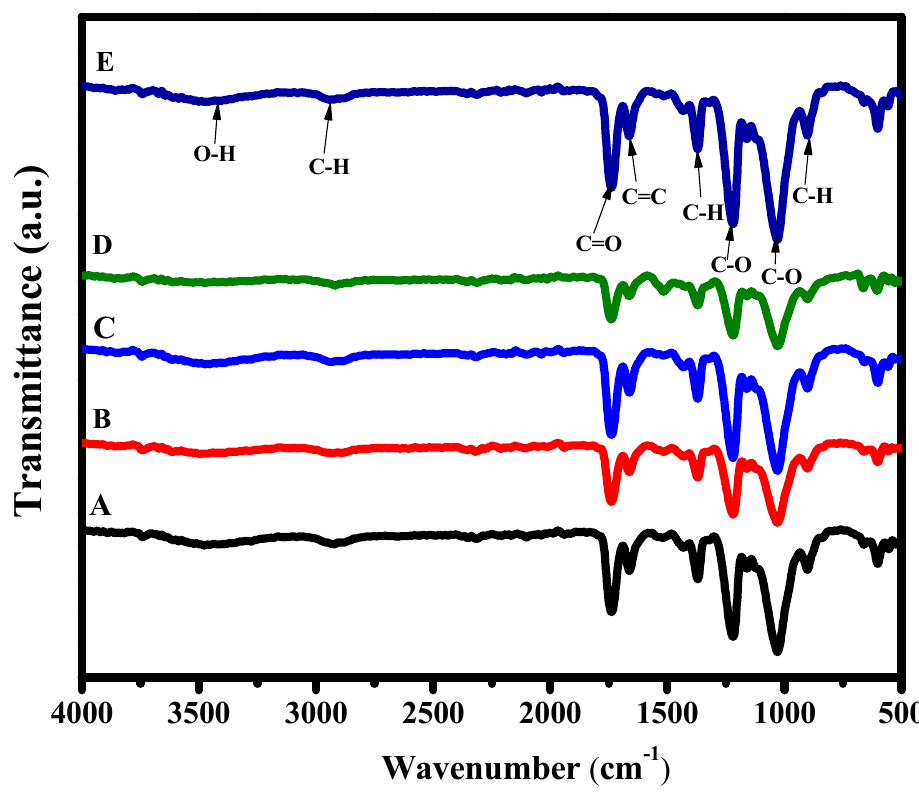
Figure 2. Fourier-transform infrared (FTIR) spectra for detecting the transmittance spectra of the different composites ( A ) CA, ( B ) Ag 2 O/CA, ( C ) ZnS/CA, ( D ) Ag 2 O/ZnS/CA, and ( E ) Ag 2 O/ZnS/GO/CA.